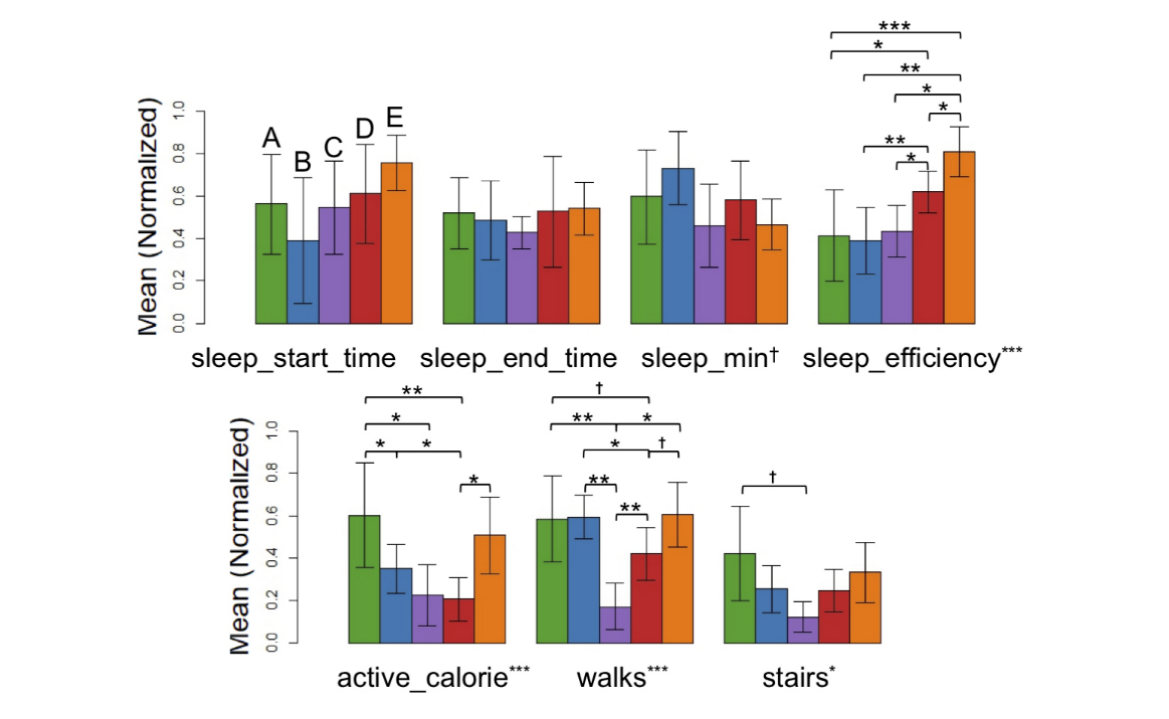
Figure 9. Bar plots of the major smartband features per cluster ( † P <.10, * P <.05, ** P <.01, *** P <.001 in analysis of variance on rank and